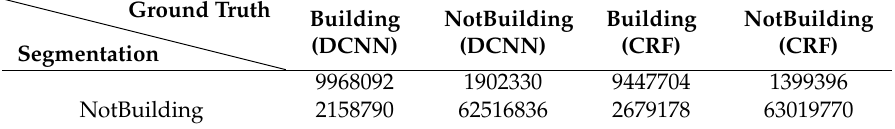
Table 4. Confusion matrices for the segmentation